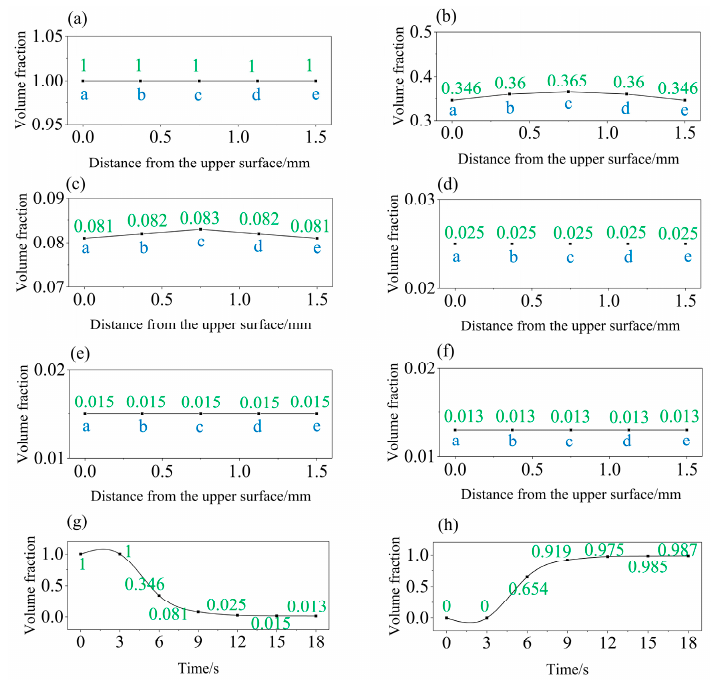
Figure 6. Variation of the phases volume fractions during quenching process: ( a ) austenite fraction at 3 s, ( b ) austenite fraction at 6 s, ( c ) austenite fraction at 9 s, ( d ) austenite fraction at 12 s, ( e ) austenite fraction at 15 s, ( f ) austenite fraction at 18 s, ( g ) austenite fraction versus time at location a and ( h ) martensite fraction versus time at location a.